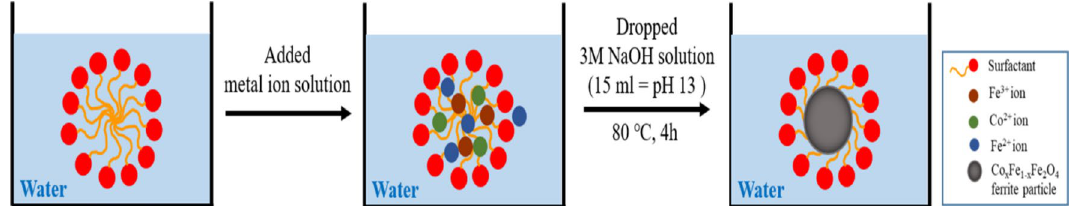
Figure 1. Surfactant assisted co-precipitation for synthesis of Co x Fe 1−x Fe 2 O 4 .